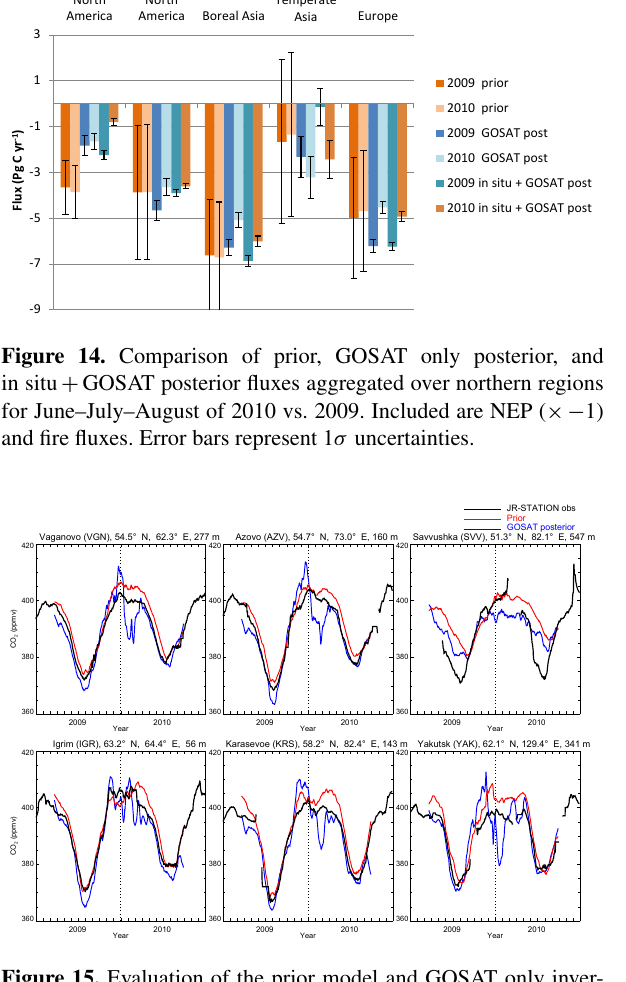
Figure 15. Evaluation of the prior model and GOSAT only inver- sion against JR-STATION in situ observations in Siberia. Shown are daily afternoon average (12:00–17:00LT, local time) mole frac- tions from the highest level on each tower, the time series of which are smoothed with a 31-day window. Sites are arranged from west to east, first at lower latitudes and then at higher latitudes, exclud- ing those with data gaps in the summer. Elevations shown include intake heights on